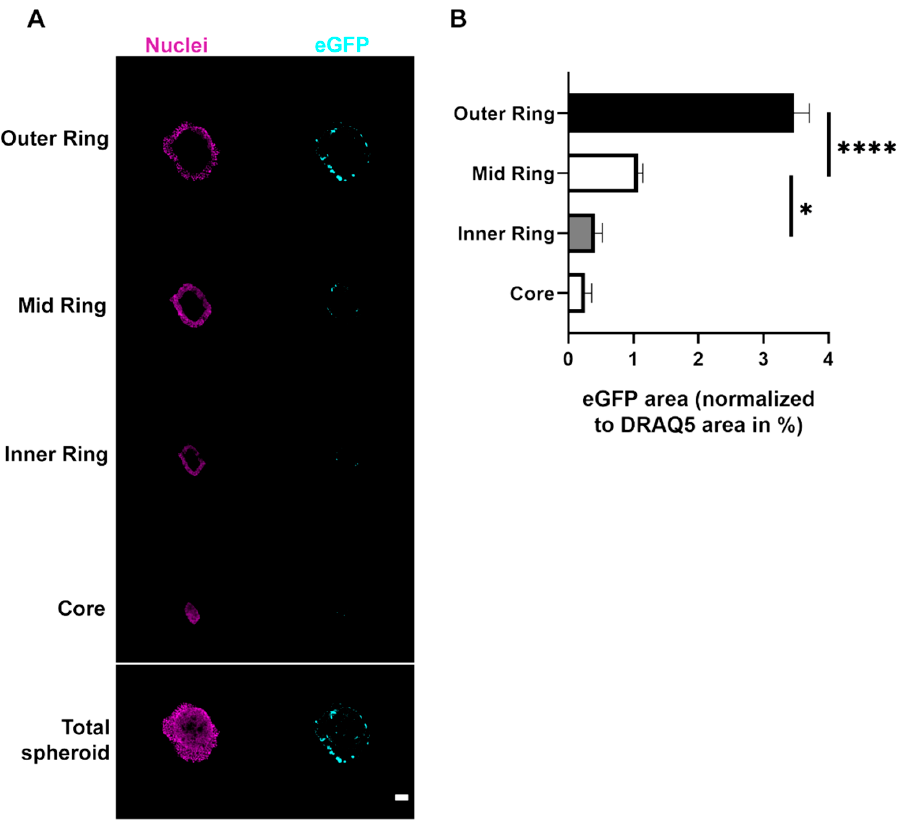
Figure 6. Triculture spheroids show highest expression of eGFP signal in the peripheral rings upon LPX transfection. For each triculture spheroid, identical amounts of cells were used and transfected with 10 ng/µL eGFP LPX, followed by fixation and staining of the nuclei. Confocal microscopy was used to visualize nuclei and eGFP at the maximum diameter of each spheroid. The segmentation and analysis were performed as in Figure 4. ( A ) Representative confocal images. Shown are whole optical sections (Total spheroid) and corresponding segments, i.e., outer ring, mid ring, inner ring, and core. Nuclei and eGFP, magenta and cyan, respectively. Scale bar, 100 µm. ( B ) Quantitative analysis. Graph shows the area of eGFP fluorescence normalized to nuclei area for each segment of triculture spheroids. Mean + SD ( n = 3 independent experiments, 3 spheroids). One-way ANOVA with Tukey’s multiple comparison post hoc test ( α = 0.05). * p ≤ 0.05, **** p ≤ 0.0001.